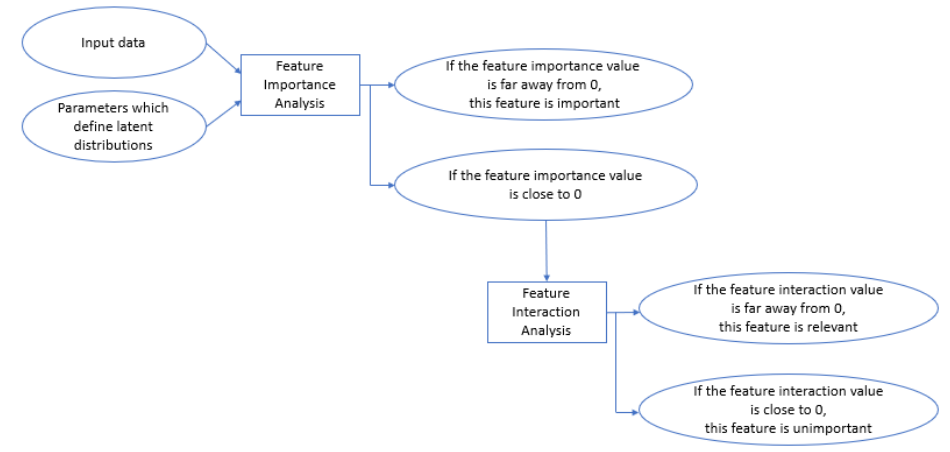
Figure 2. Flow chart of applying sensitivity analysis to interpret VAE.